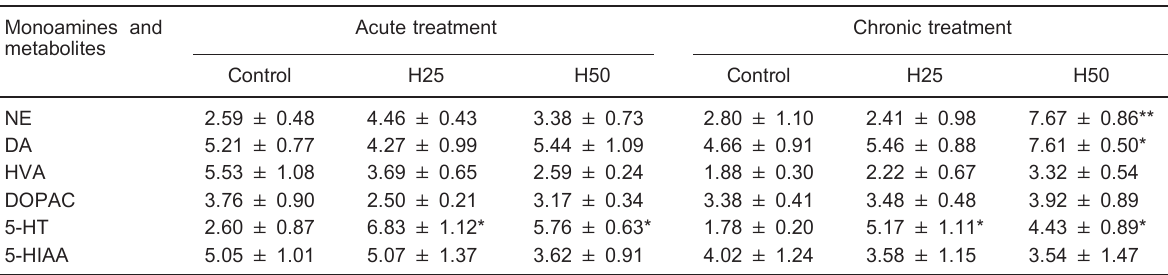
Table 1. Determination of levels of monoamines and metabolites in striatum of mice treated with Hoodia gordonii , using high performance liquid chromatography (HPLC). Monoamines and